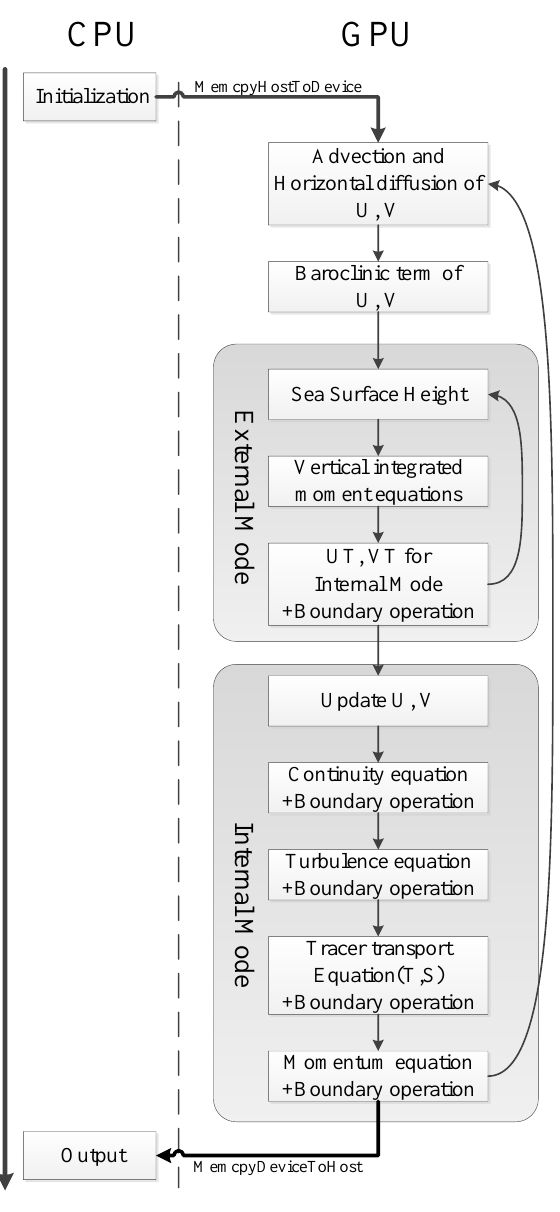
Figure 2. POM.gpu